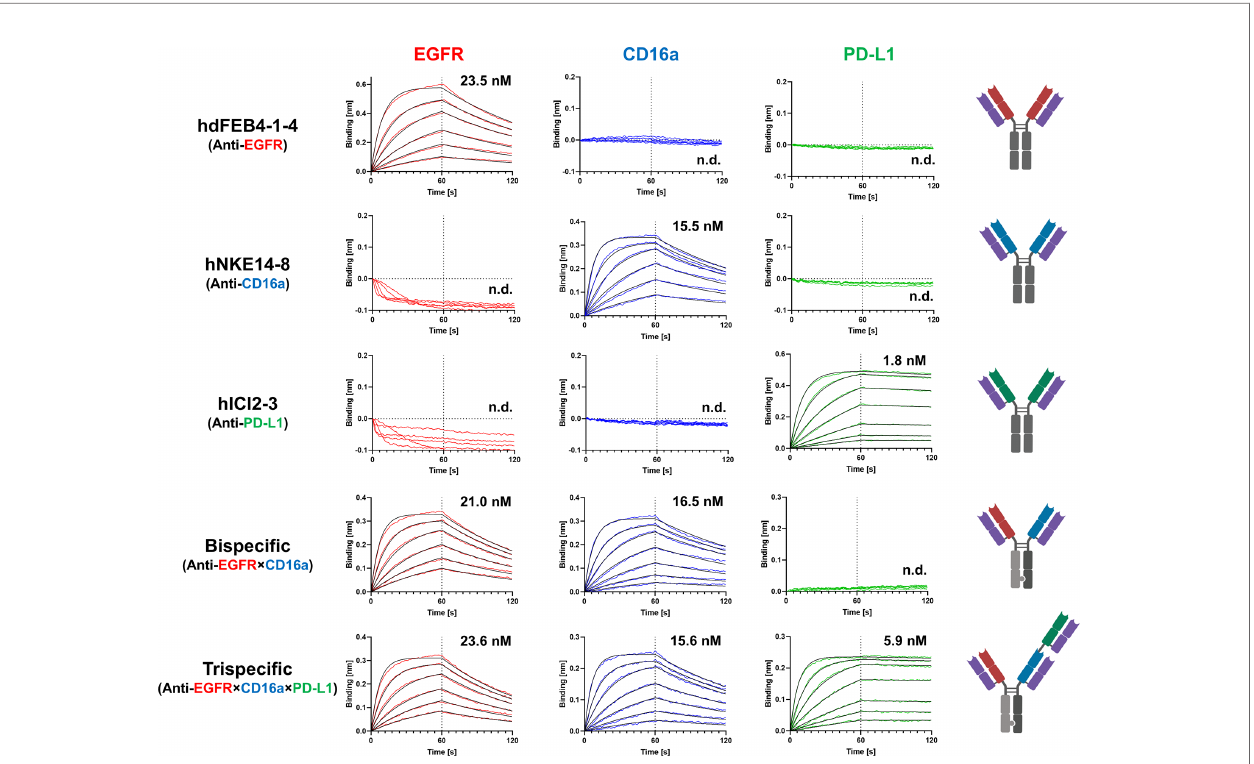
FIGURE 4 | BLI-measurements of humanized mono-, bi-, and trispeci fi c antibodies against EGFR, CD16a, and PD-L1. While all antibodies bind exclusively to their respective target with distinguished af fi nity, the trispeci fi c antibody binds all three